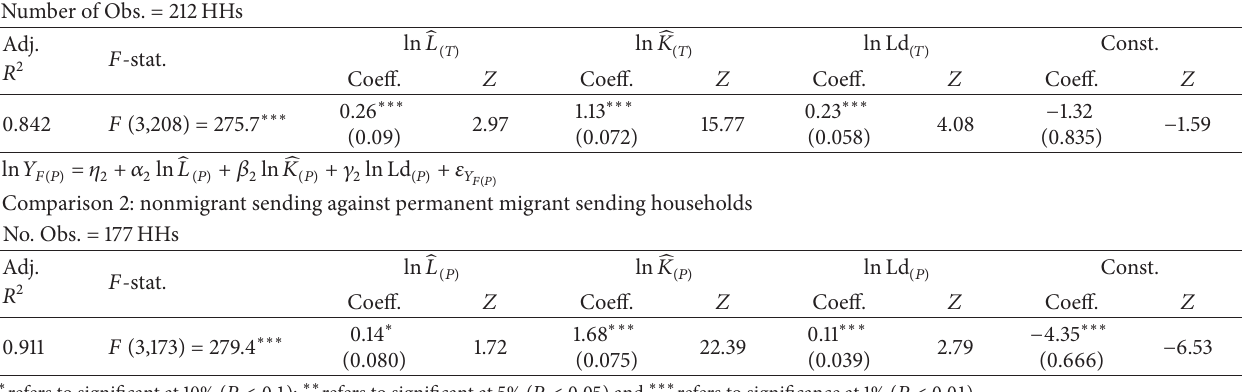
Table 3: Second stage estimation